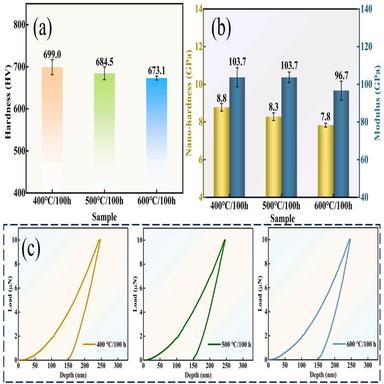
Mechanical properties of Ni55Ti37Hf8 alloy after different medium-to-high temperature heat treatments. (a) Vickers hardness, (b) Nano-hardness and elastic modulus (c) Loading/ unloading curves of alloys.